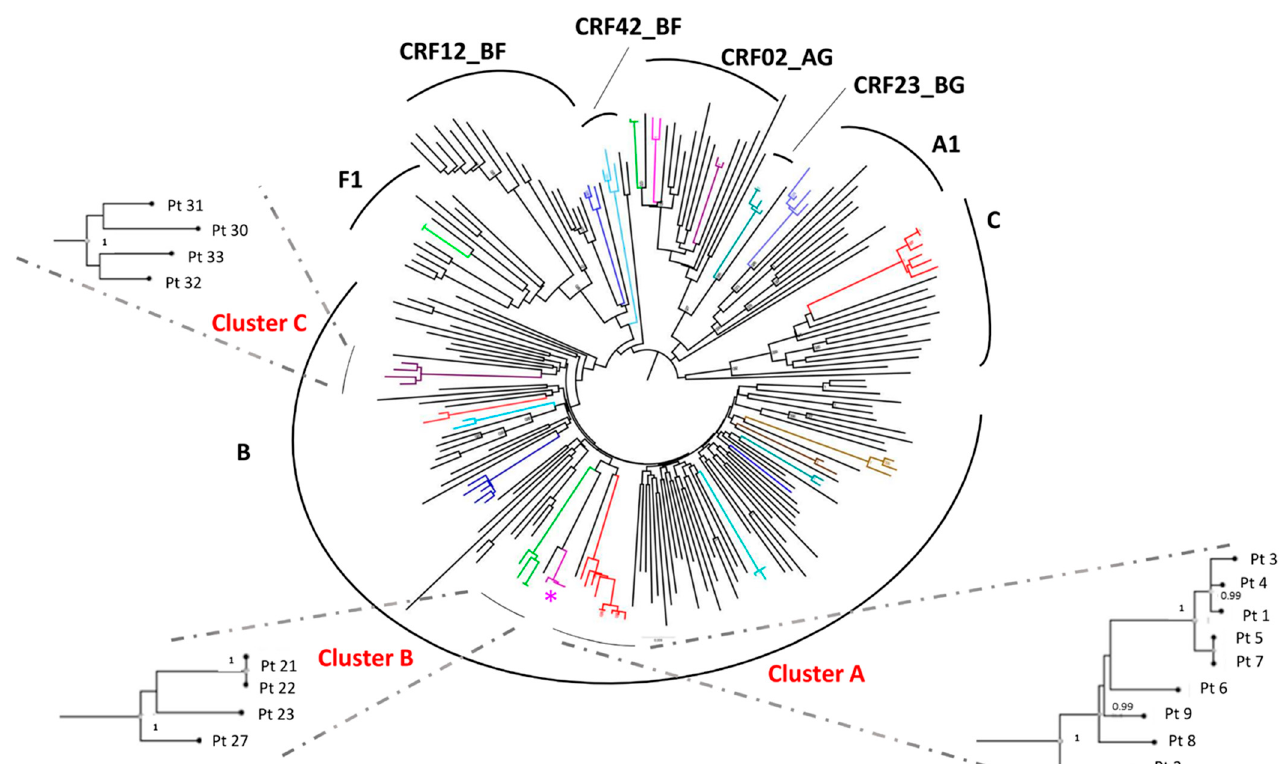
Figure 1. Phylogenetic tree constructed with pol population sequences according to subtypes. Bayesian phylogenetic tree constructed by all pol sequences from the study subjects ( n = 229) highlighted 20 colored TC (8 pairs and 12 TC ≥ 3 individuals) using a genetic distance ≤ 0.015. The asterisk shows the resistant cluster carrying the protease inhibitor resistance I85V. In the inserts, the largest TC of subtype B are shown, with the significance of the sub-cluster nodes (posterior probability). Abbreviation: Pt,